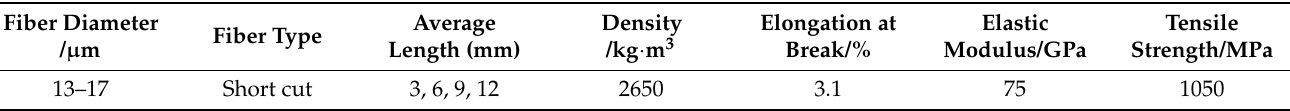
Table 2. Physical and mechanical properties of basalt